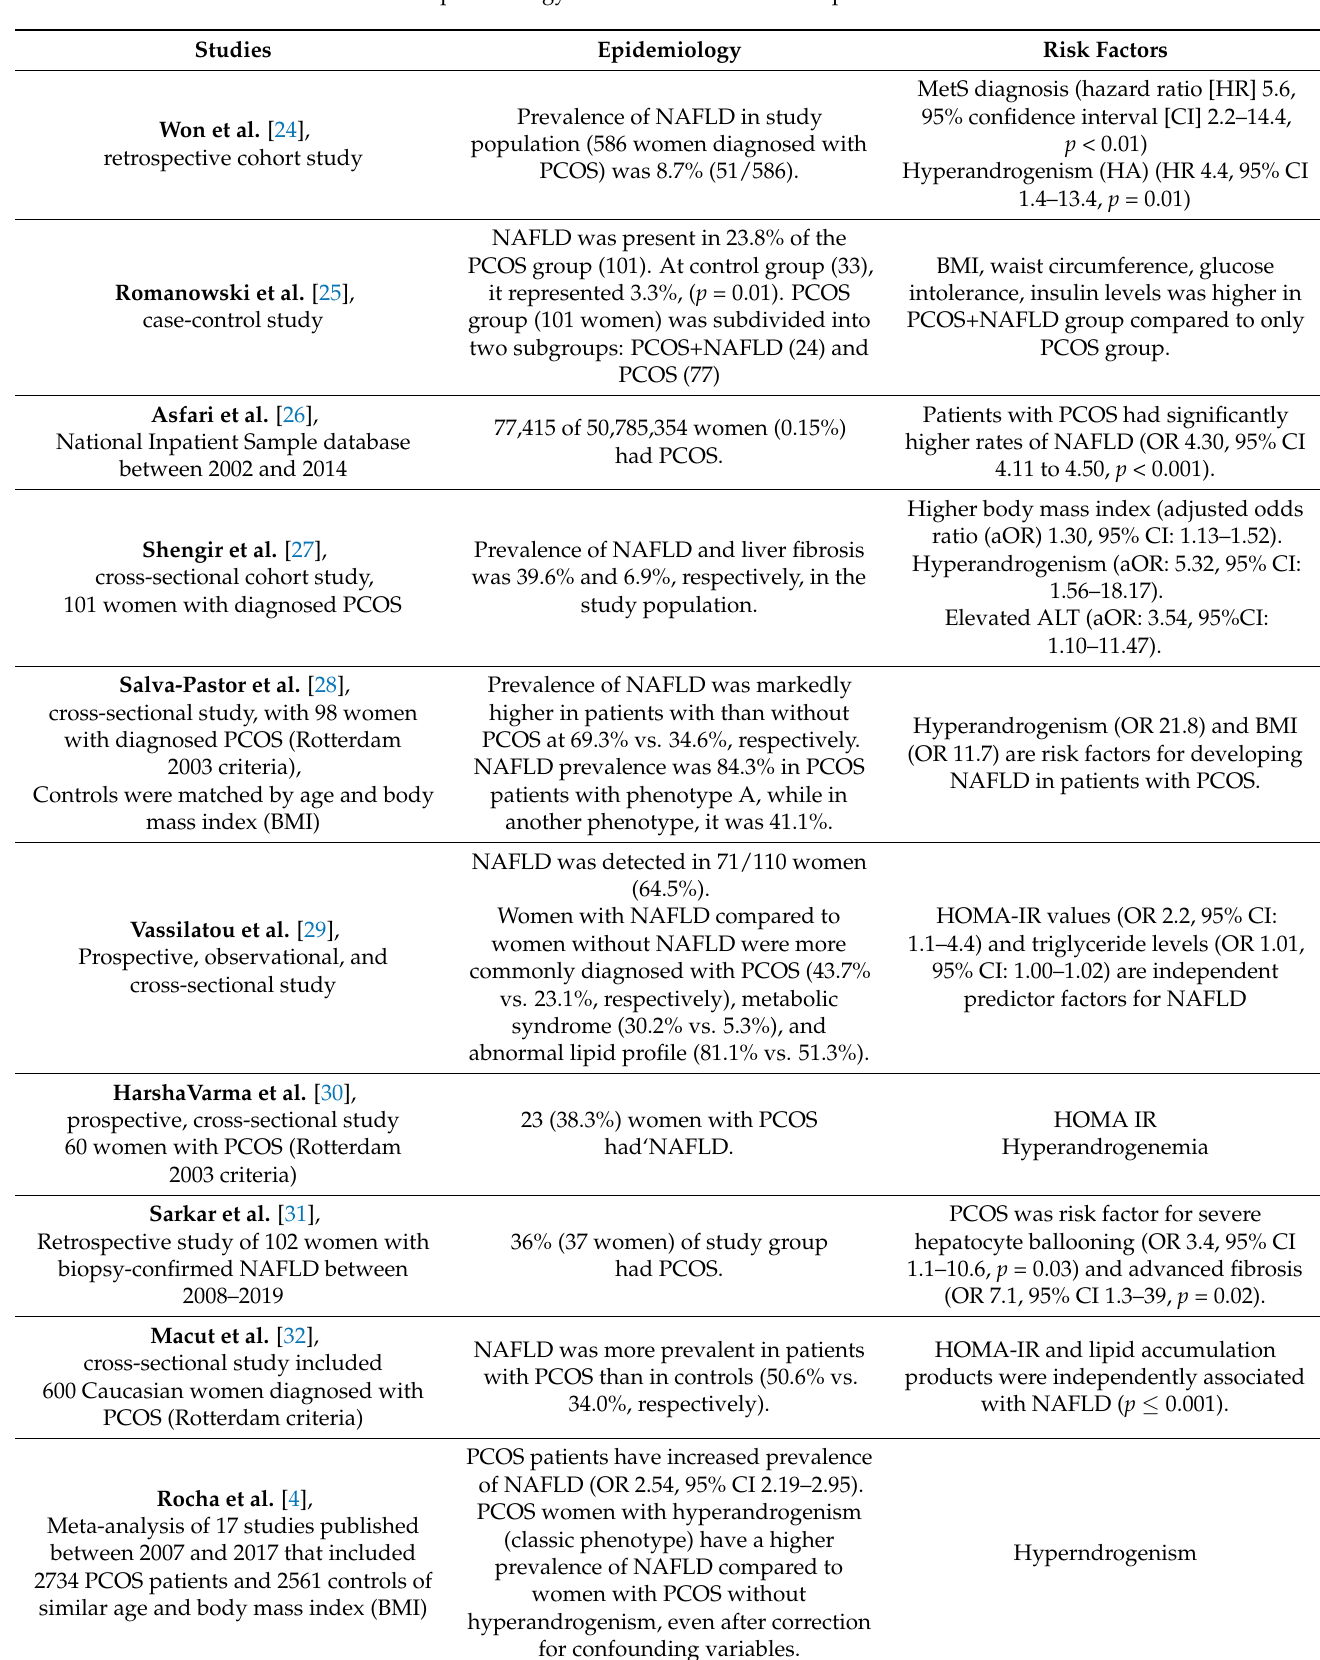
Table 1. Epidemiology and risk factors for development of NAFLD in PCOS